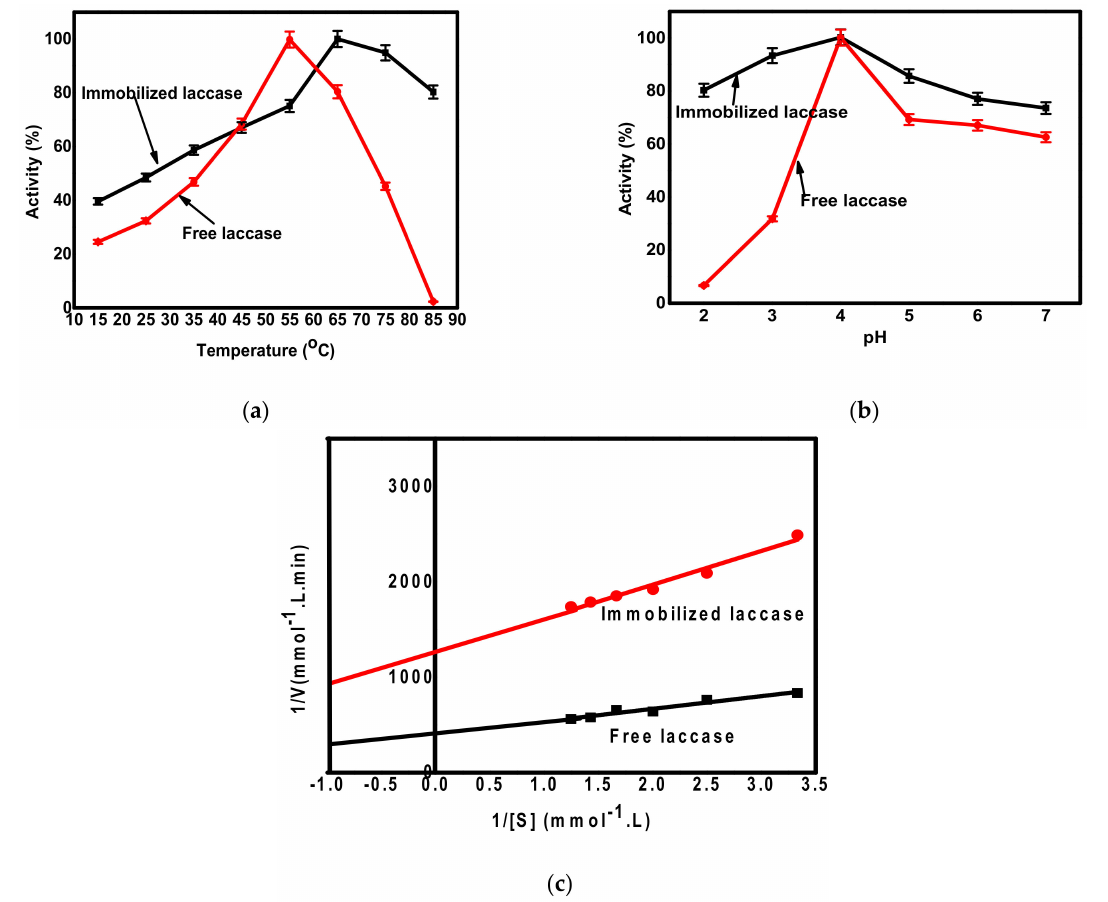
Figure 4. ( a ) The effect of the temperature and ( b ) pH and ( c ) the Lineweaver–Burk plots of the free and immobilized